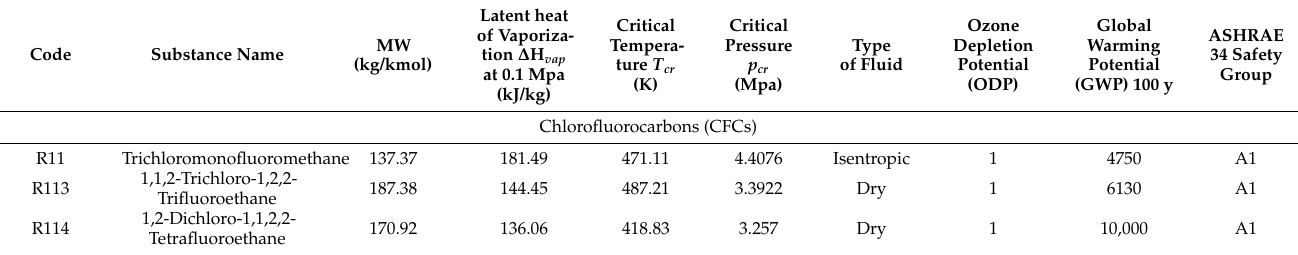
Table 2. Thermodynamic properties, environmental parameters, and safety classification of various fluids (n.a.: not